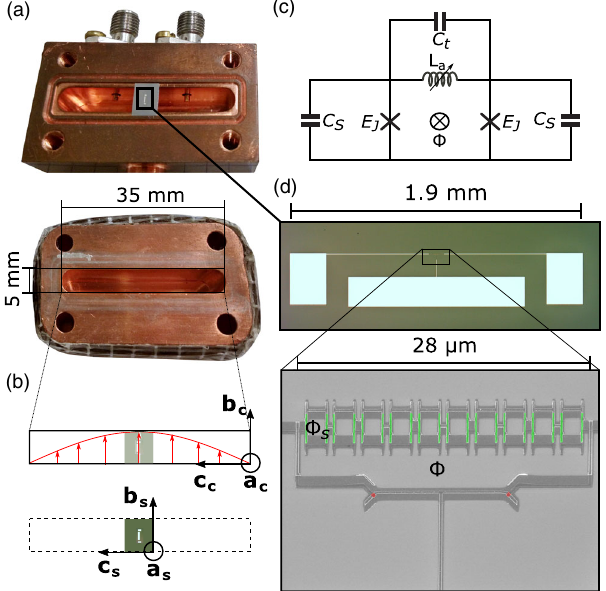
FIG. 2. Quantum circuit with nonperturbative cross-Kerr cou- pling. (a) Picture of the two parts of the Copper-OFHC 3D cavity with the input-output pin connectors. The sample is placed at the center of the cavity. (b) The electric field distribution of the first EM mode of the cavity in the center plane is sketched in red. The cavity directions ( a c , b c , c c ) and sample directions ( a s , b s , c s ) are represented. (c) Lumped element of the transmon molecule circuit. (d) Optical microscope and SEM pictures of the transmon molecule sample. The Josephson junctions are highlighted in red. The SQUID Josephson junctions implementing the coupling inductance L are highlighted in a